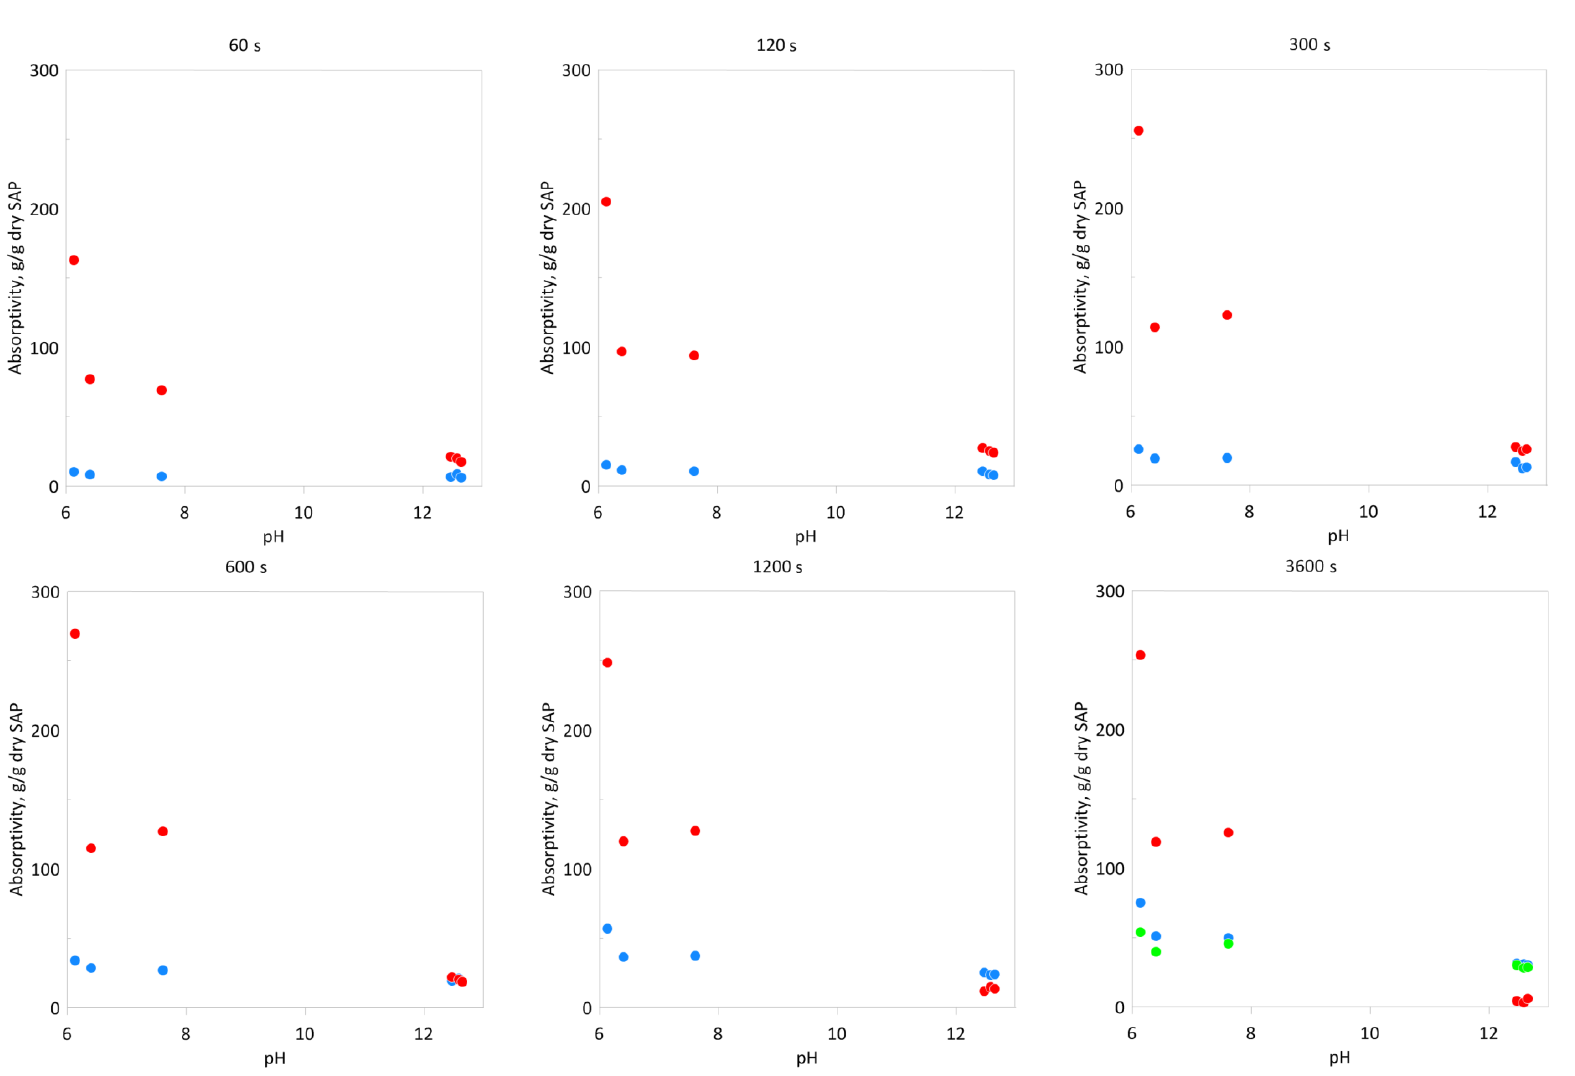
Figure 4. Absorptivity of superabsorbent polymers depending on time and pH of the solution: ● Cablock CT, ● Hydropam, and ● Creasorb SIS.